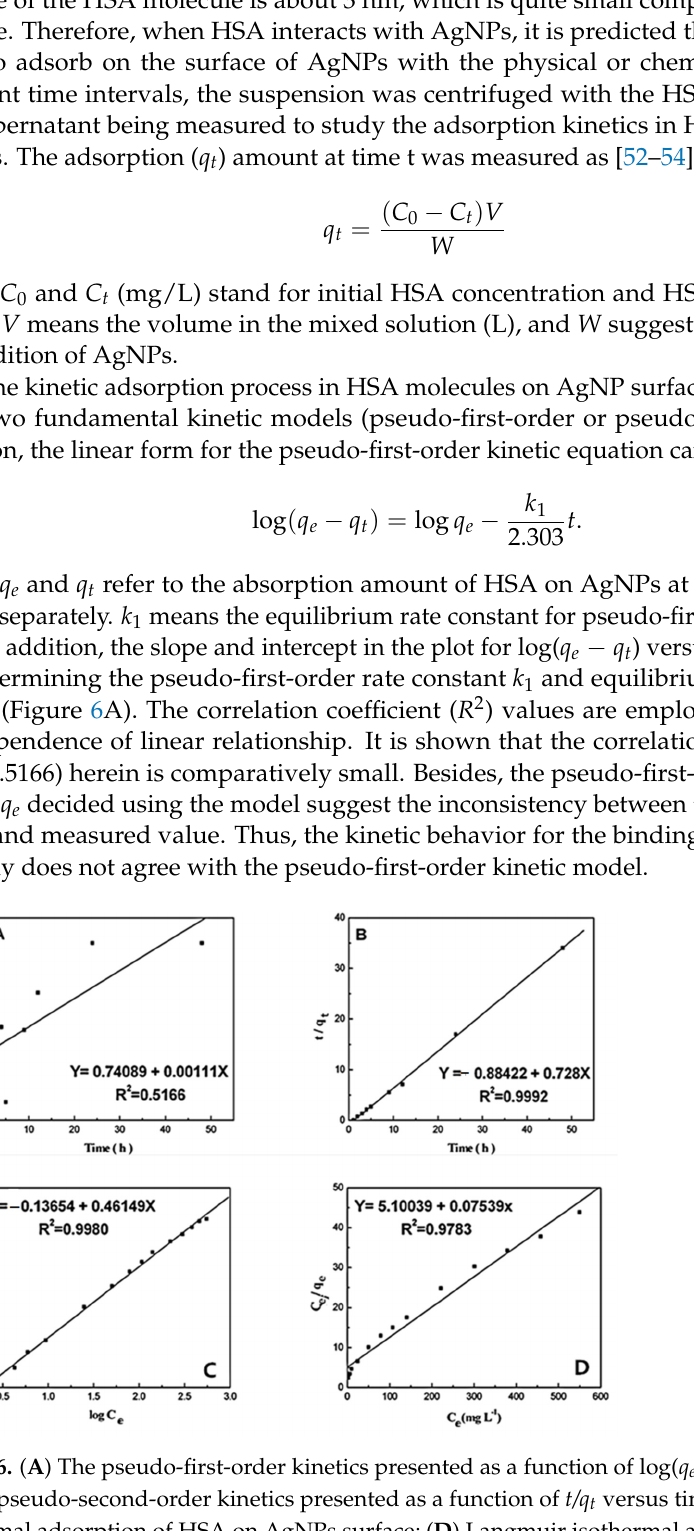
where k 2 means the equilibrium rate constant for pseudo-second-order adsorption. Ac- cording to slope and intercept, the second order rate constant k 2 and q e values were de- cided (Figure 6B). According to Figure 6B, the correlation coefficient (R 2 = 0.9992) indicates the strength in the linear relationship. Additionally, it seems that the theoretical q e value is perfectly consistent with that of the experimental value. As a result, it can be confirmed that HSA adsorption on AgNPs is in line with the pseudo-second-order kinetics. The adsorption process of protein on NPs surfaces in biological fluid is usually por- trayed using Freundlich and Langmuir isotherms. The Freundlich isotherm is an empiri- cal formula, which is used on the assumption that protein molecules have multilayer ad- sorption on the surface of NPs. However, Langmuir isotherm is proposed according to the assumption that protein molecules have monolayer adsorption on NPs surfaces. The adsorption parameters of the HSA-AgNPs system were fitted with Freundlich and Lang- muir adsorption equations linearly in order to investigate the optimal isothermal adsorp- tion models. Figure 6C,D shows the adsorption isotherms for HSA on the AgNPs surface at room temperature. In this case, HSA and AgNPs represent the adsorbate and adsorbent, separately. Multilayer adsorption on NPs surfaces is measured using the Freundlich ad- sorption isotherm model, which can be given as the following equation: 1 n e